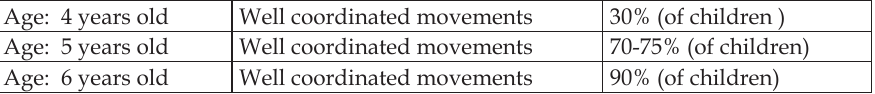
Table 2. Comparative format of the percentage of well coordinated